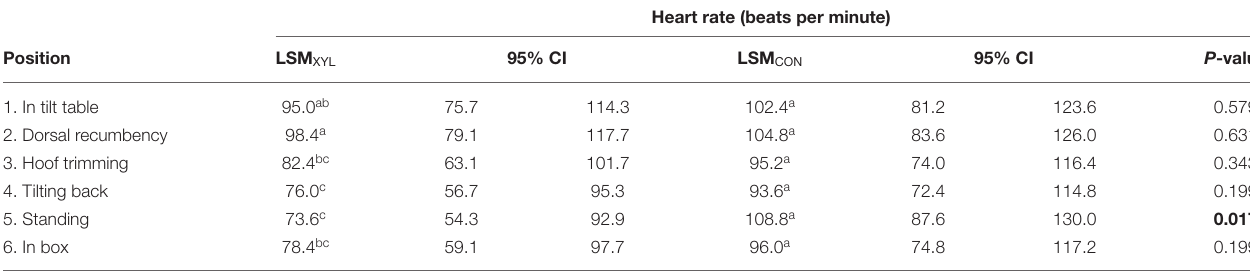
Heart rate (beats per minute)